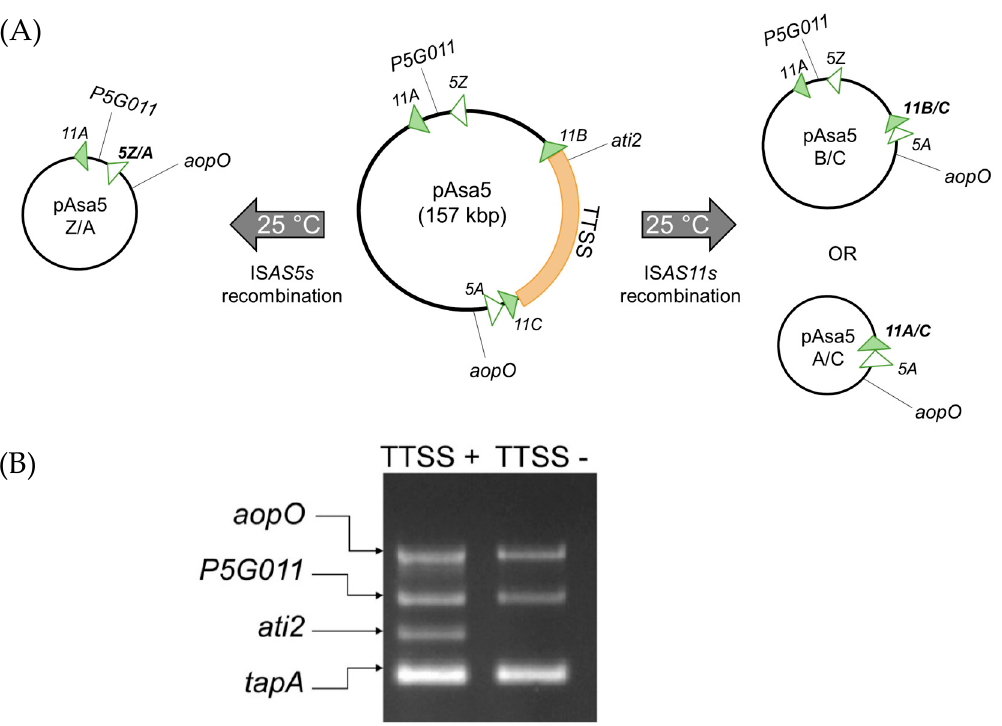
Figure 1. ( A ) Schematic representation of 3 recombination patterns of pAsa5 according to the ISs present on the plasmid. The region in orange corresponds to the TTSS locus, the IS AS11 s are represented by green triangles and the IS AS5 s are shown by white triangles. This figure is inspired by Tanaka et al. [8] ( B ) An example of the PCR multiplex result from the SHY14-2246 strain, which contains an unaltered pAsa5 plasmid (TTSS+) and a strain that has lost its TTSS genes (TTSS − ) generated from SHY16-3432 parental strain. The AopO and P5G011 genes are located downstream and upstream, respectively, of the region encoding the TTSS. The third gene corresponds to ati2 , which is located inside the TTSS locus. The last gene ( tapA ) is located in the chromosome and it is used as a positive control.